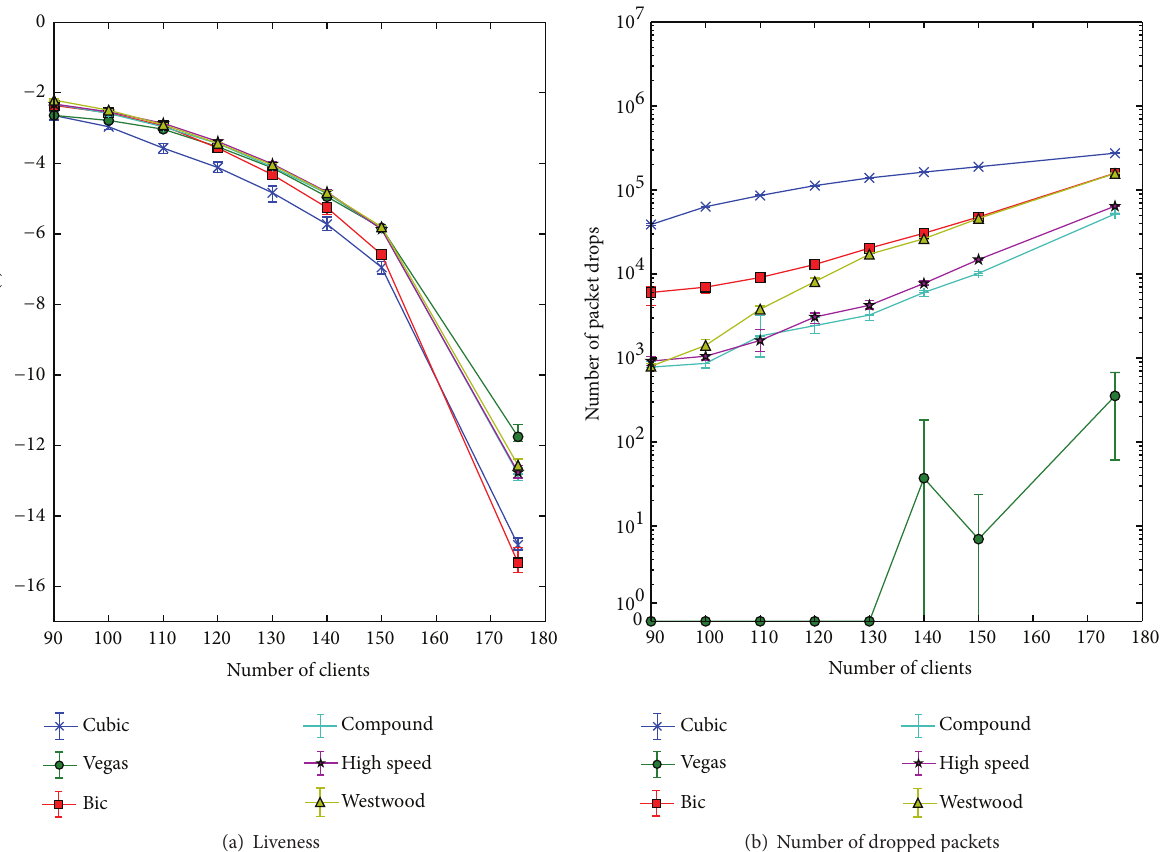
Figure 6: Performance of alternative TCP congestion control